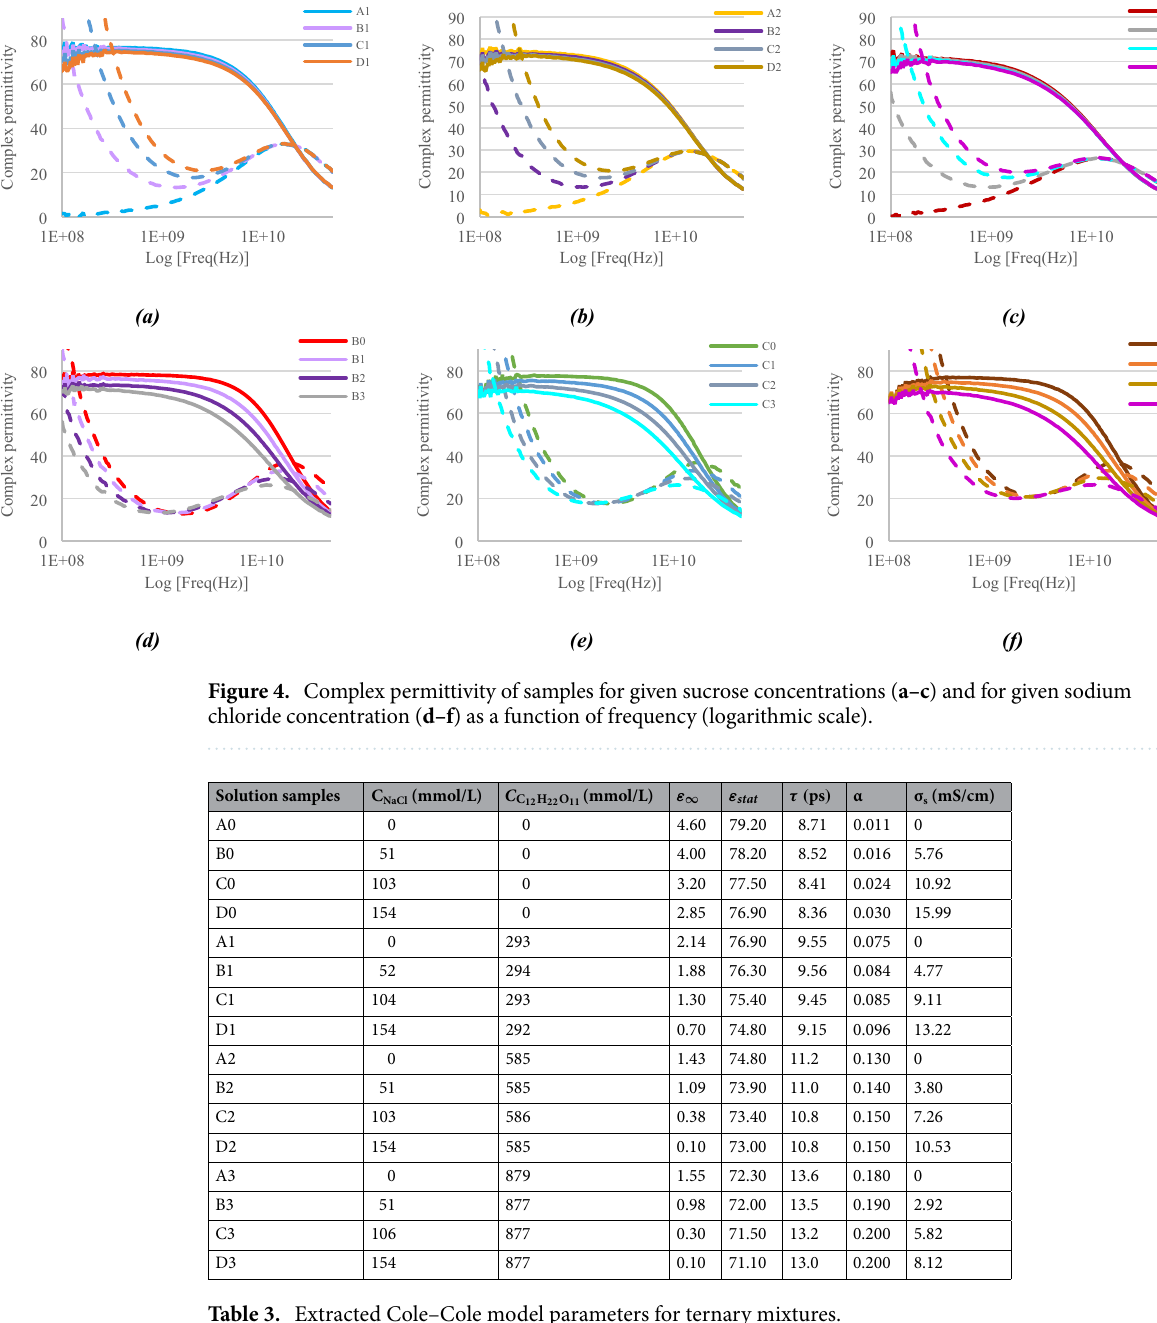
Table 3. Extracted Cole–Cole model parameters for ternary mixtures.